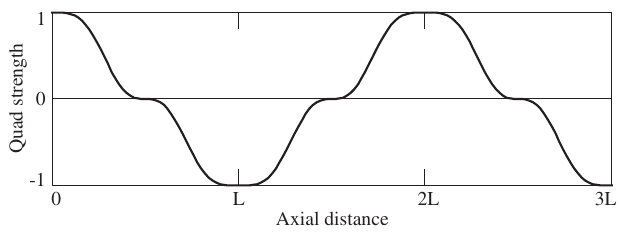
FIG. 4. Axial profile of normalized quadrupole strength h (cid:1) z (cid:2) for smooth field model #4, which uses only the 3rd and 5th harmonics. The unit cell length is 2 L